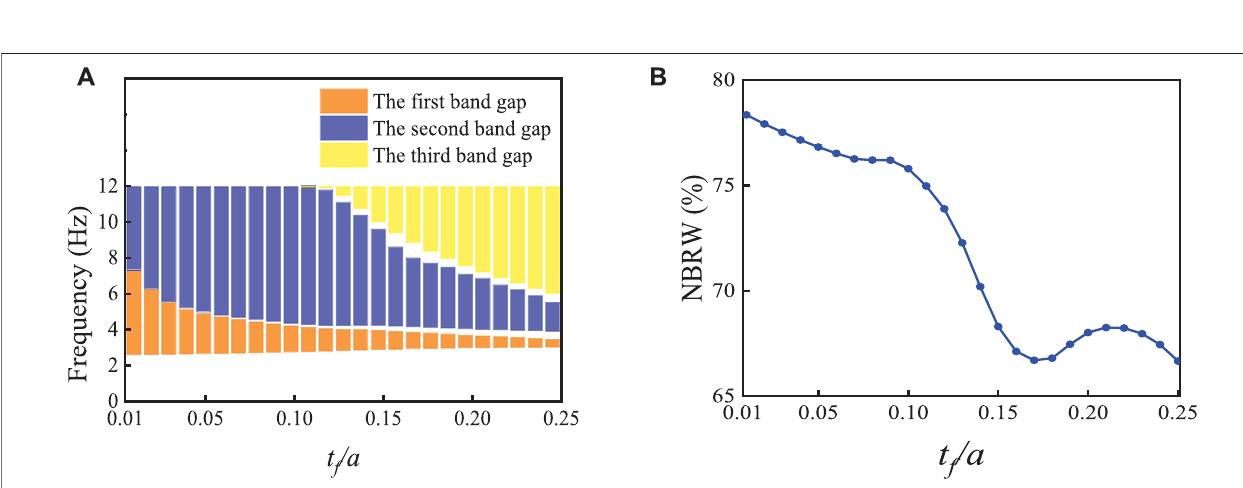
Frontiers in Materials |